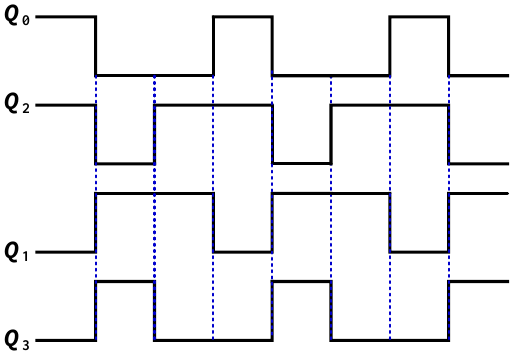
Figure 8. Operating states of the proposed equalizer without using Q 4 at V B 0 > V B 1 . ( a ) charge state; ( b ) discharge state; ( c ) release state.